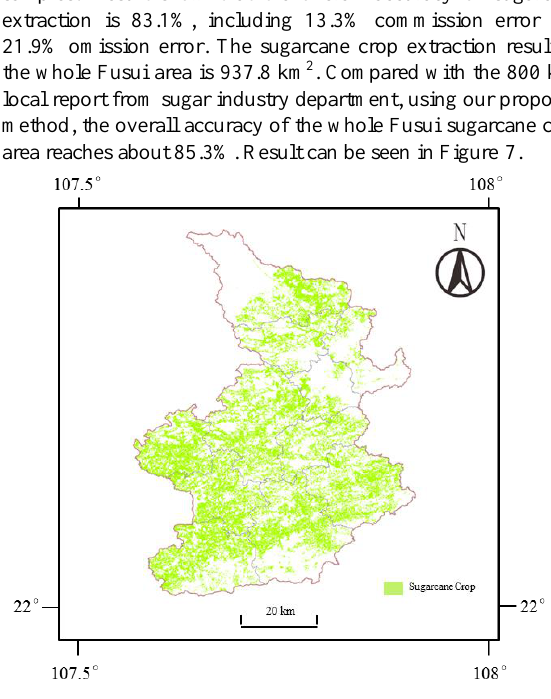
Figure 7 Sugarcane crop extraction of Fusui,